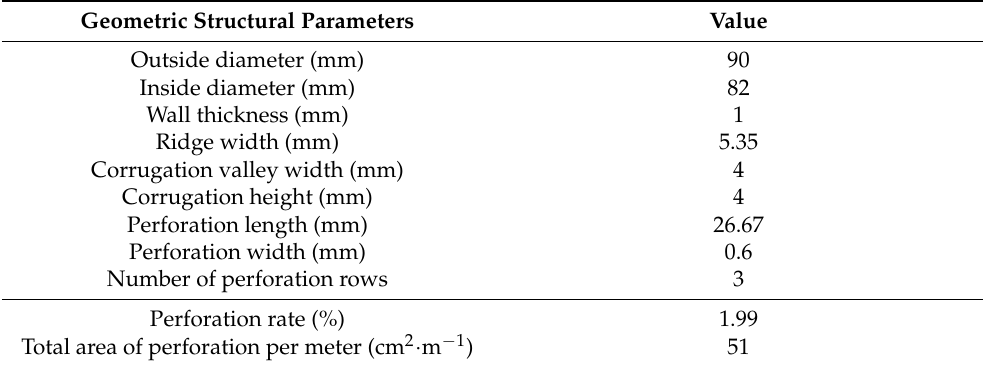
Figure 4. Sketch of the subsurface drainage corrugated pipe. k = corrugation height; c = corrugation pitch; j = corrugation valley width. Table 1. Corrugated pipe and perforation design used in the sand tank experiments.